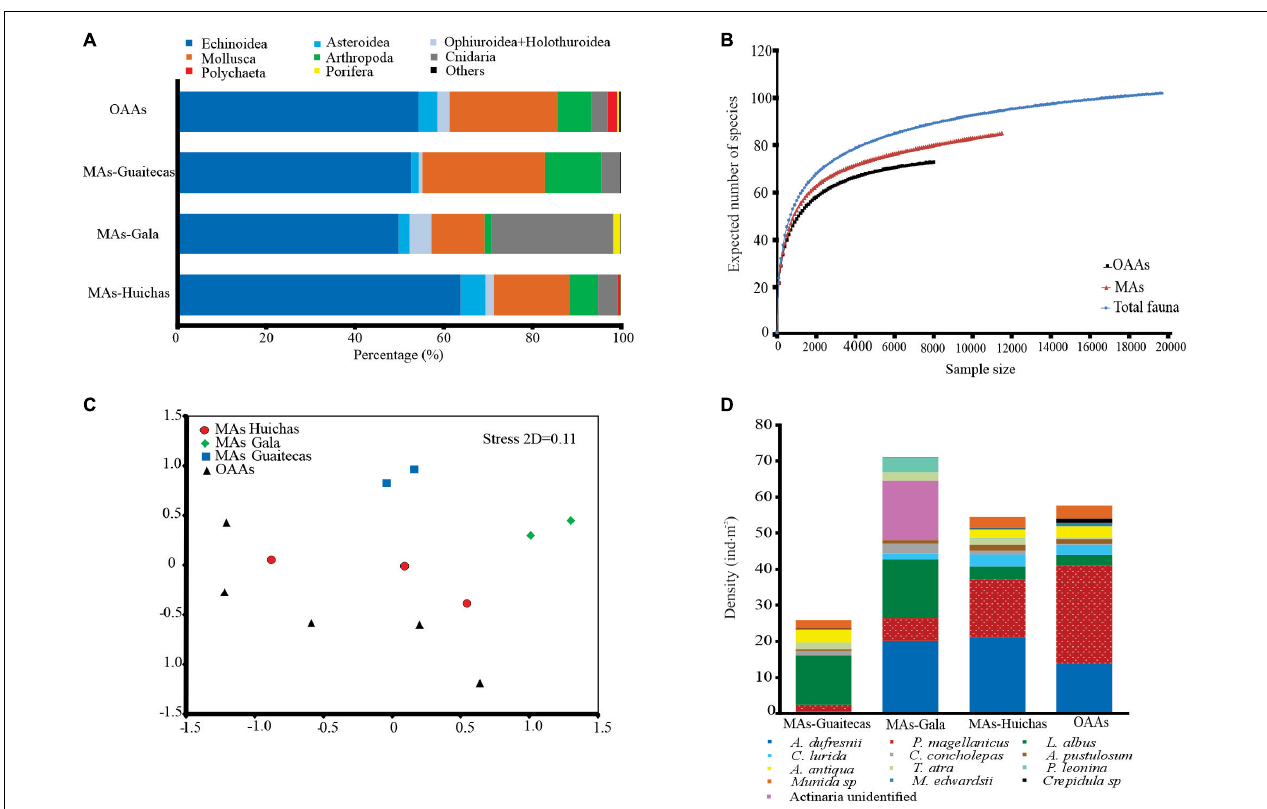
FIGURE 4 | (A) Benthic fauna contribution in terms of density in percentage (%) for main taxonomic groups. Others: Ascidiacea, Nemertea, Echiura, and Platyhelminthes. (B) rarefaction (ES) plot for the benthic fauna enumerated in MAs, OAAs and for total benthic fauna (MAs + OAAs). (C) Non-metric multidimensional scaling analysis (nMDS), showing OAAs (black triangles), MAs-Huichas (red circles), MAs-Guaitecas (blue squares), MAs-Gala (green diamonds). (D) Densities of the principal species contributing to dissimilarity between areas. The list is based on the species that contribute to > 50% cumulative of the dissimilarity according to SIMPER analysis.